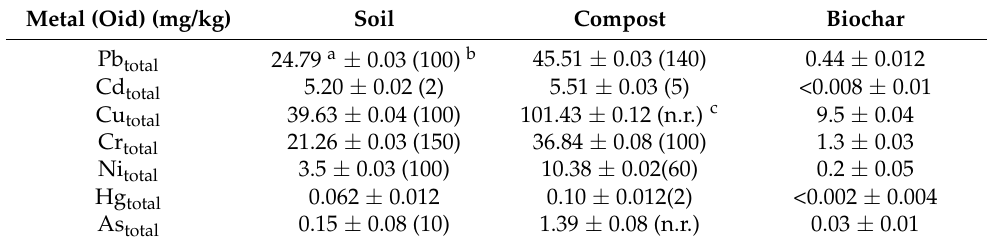
Table 2. Total contents of trace elements in substrates.